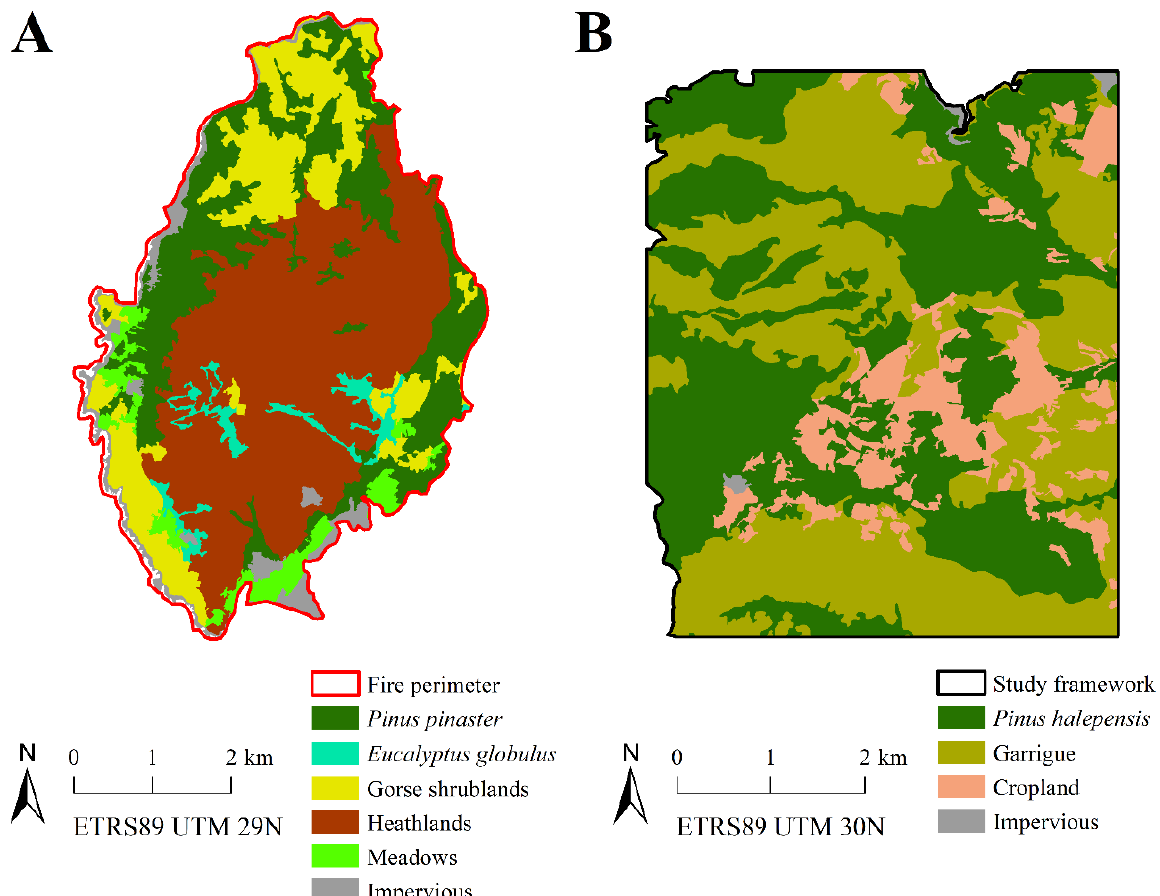
Figure 3. Pre-fire land cover derived from the Spanish Forest Map for the Atlantic ( A ) and Mediter- ranean ( B ) study sites.